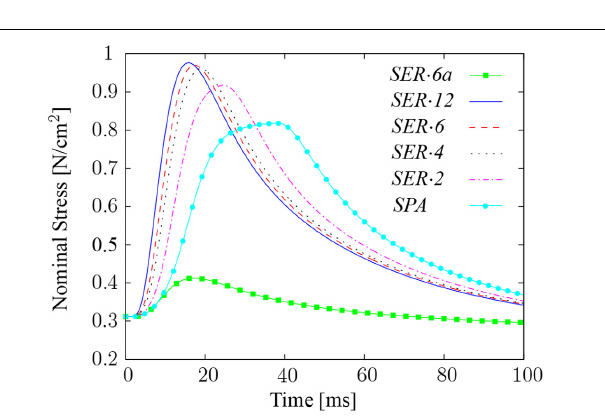
FIGURE 9 | Distribution of membrane potential, V m in [mV], and contraction-induced deformation during single twitch contractions of models SPA ( t = 22ms after stimulation), SER · 2 ( t = 10ms), SER · 6 ( t = 5ms), and SER · 12 ( t = 2ms) (from top to bottom).